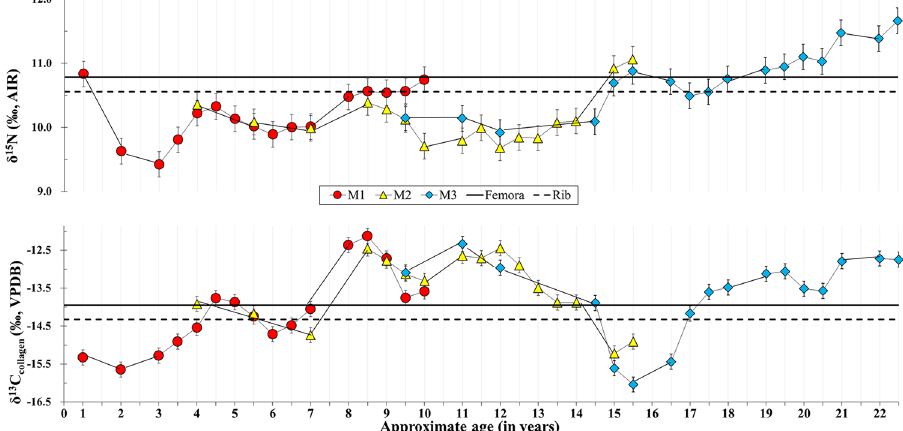
Figure 6. Nitrogen and carbon isotopic profiles of teeth serial